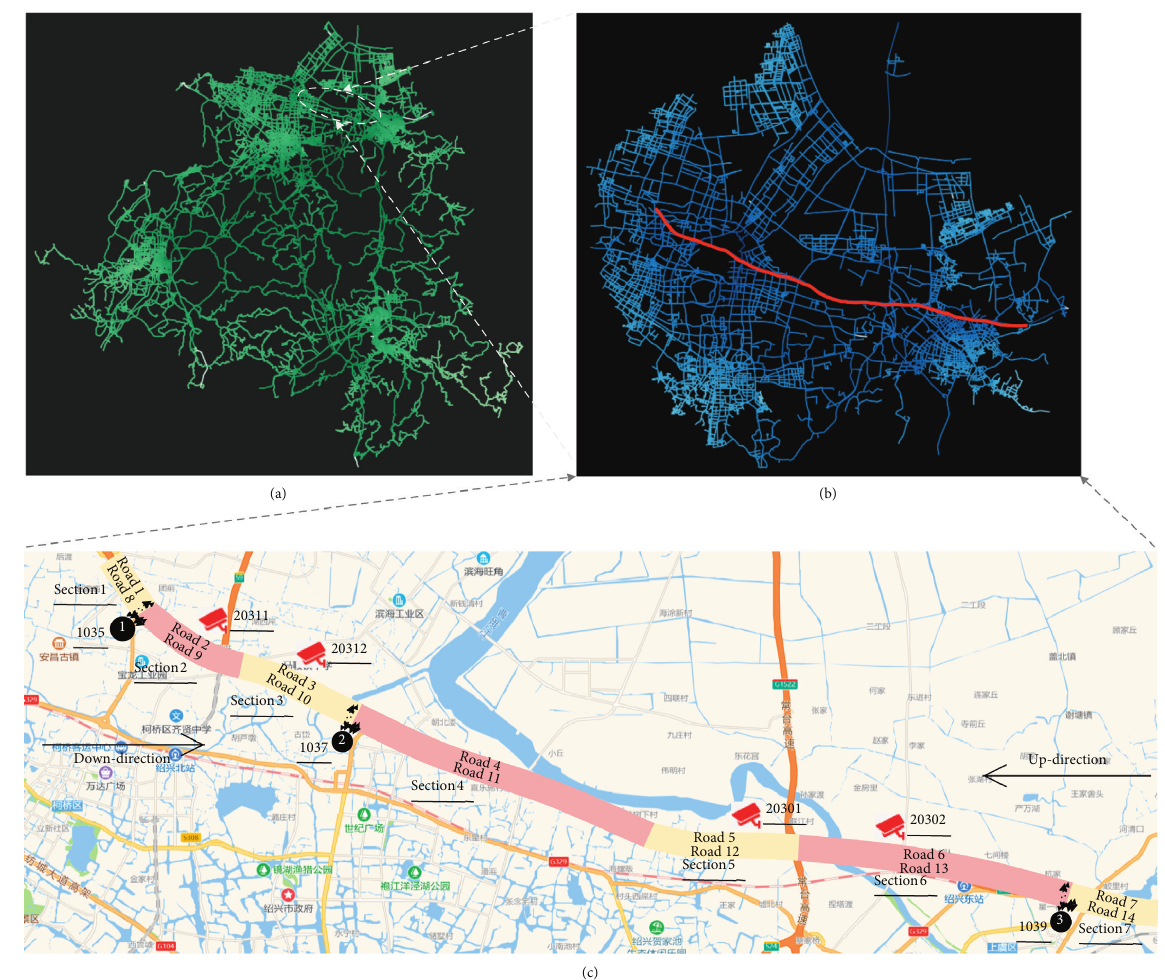
Figure 2: Target